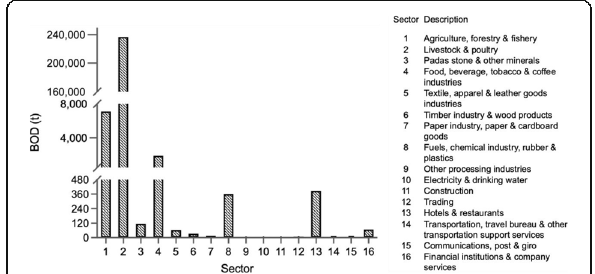
Fig. 3 Sectoral direct discharge of BOD in the 2007 Balinese economy